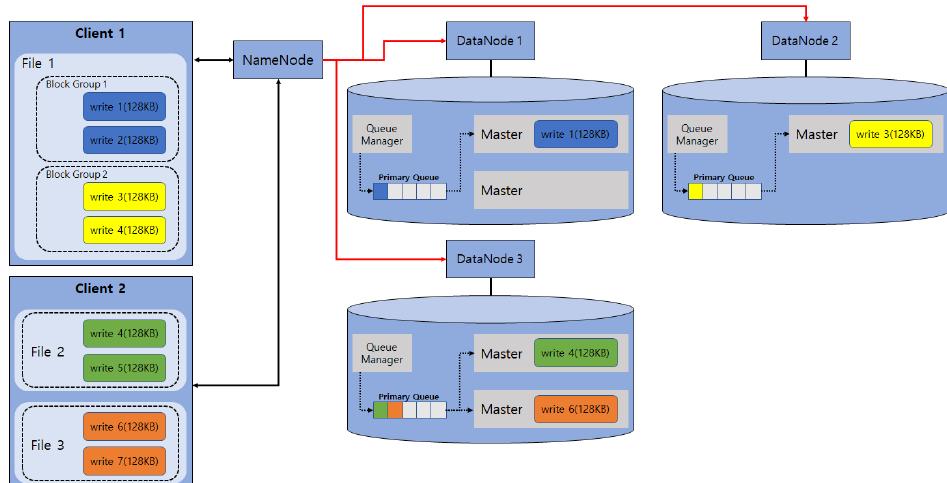
Figure 2. Multiple I/O process in the EC-based HDFS.